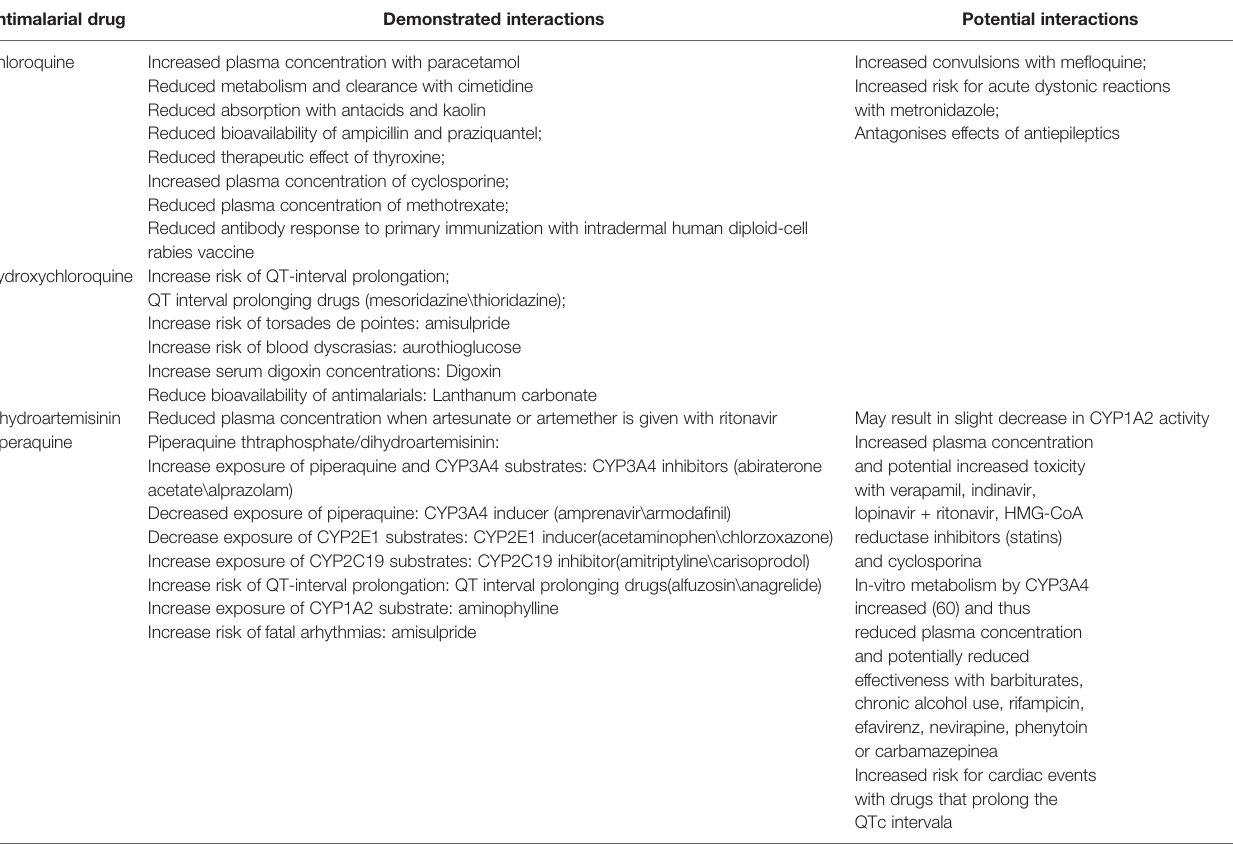
TABLE 5 | Demonstrated interactions of CQ and its analogs (Li J. et al.,